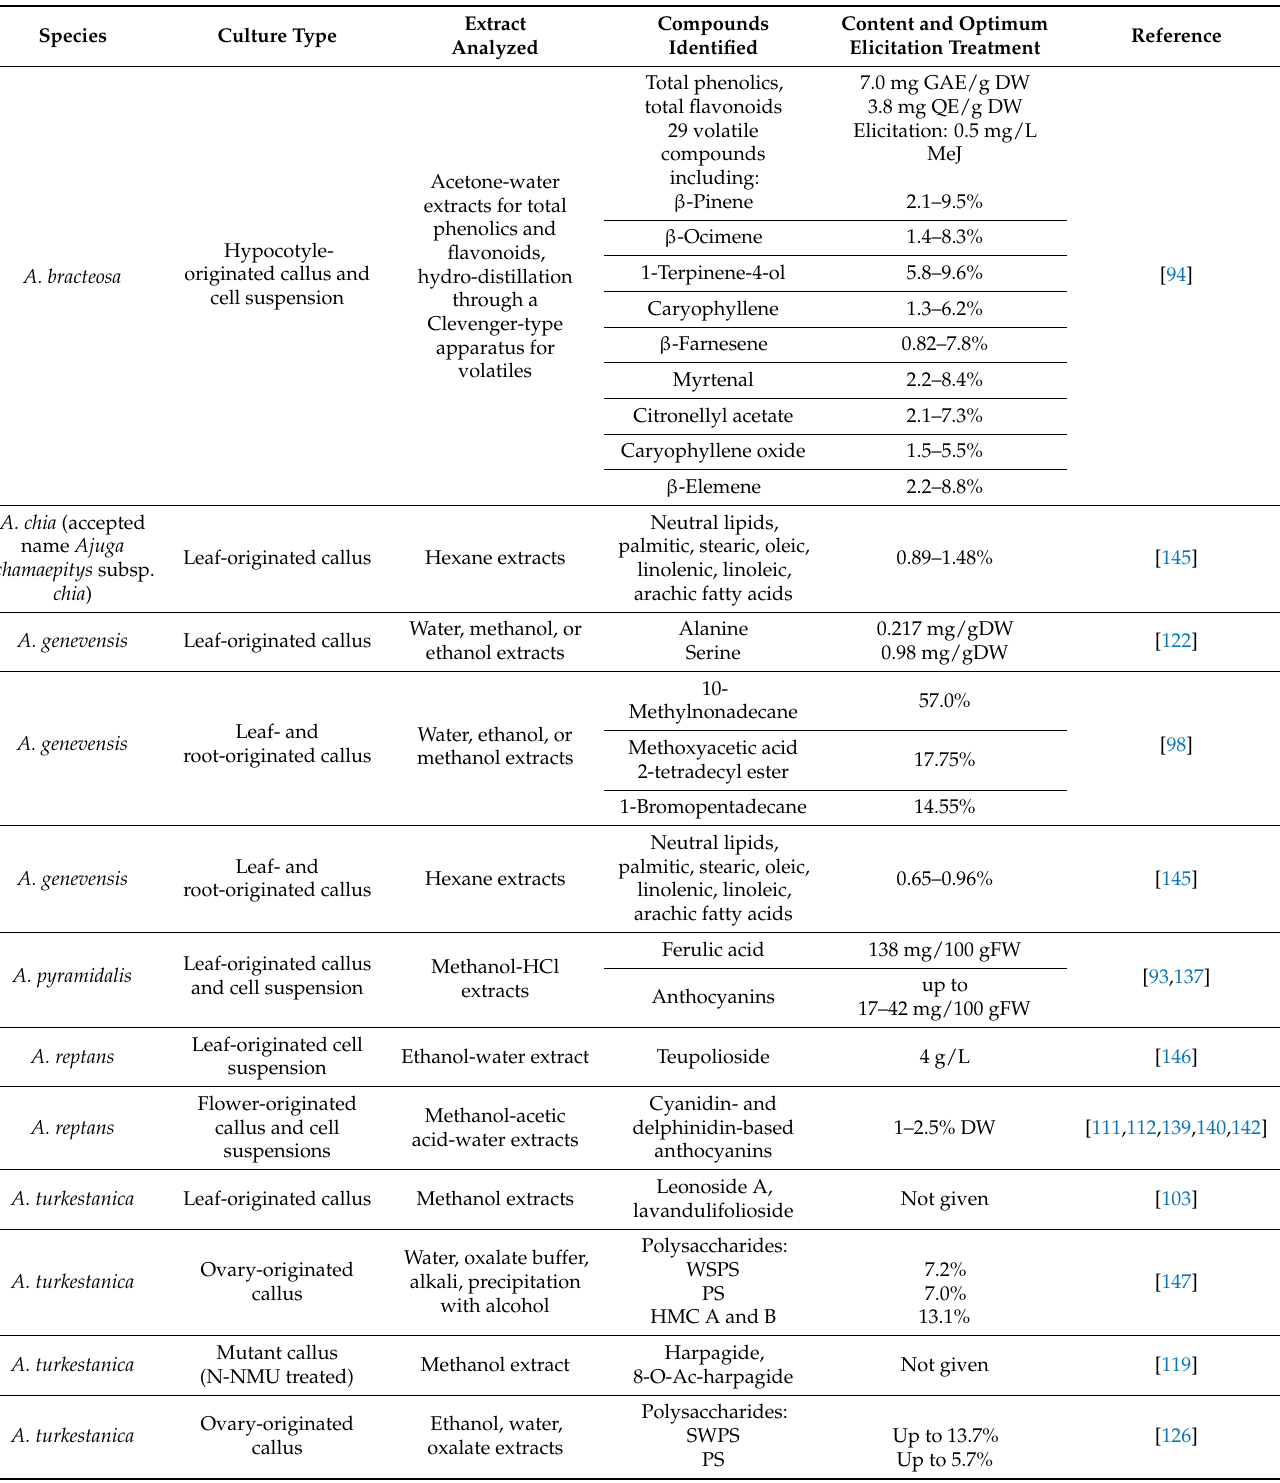
Table 4. Compounds of different chemical classes found in Ajuga spp. cell